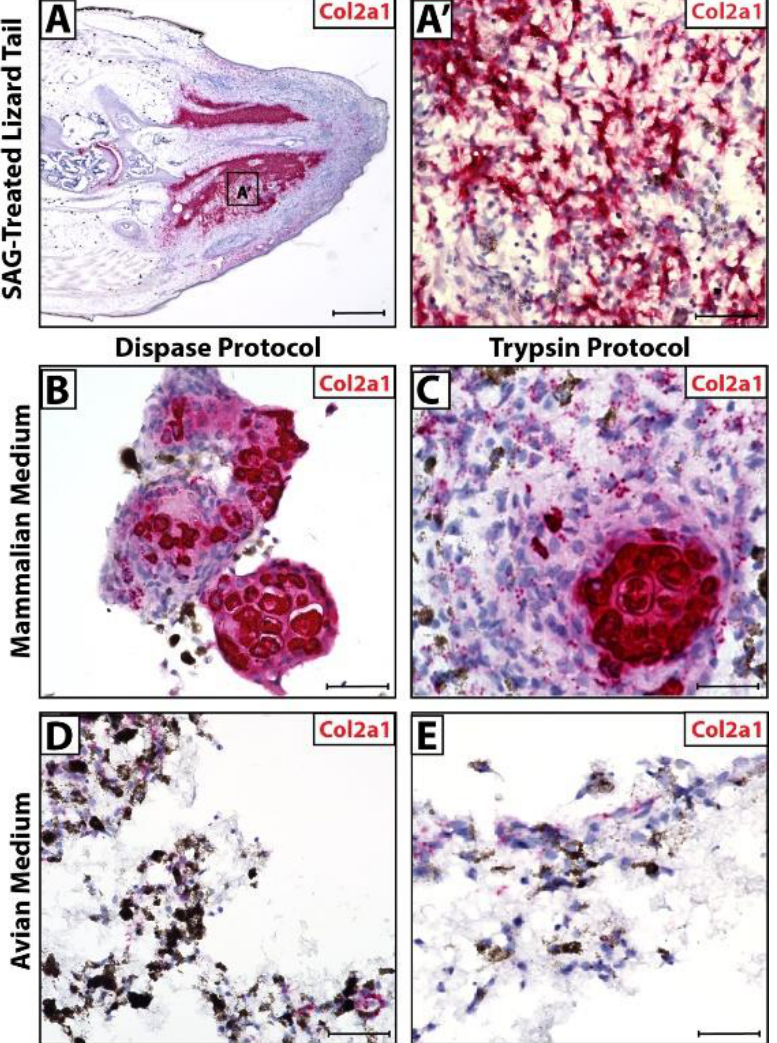
Figure 4. Micromass blastema organoid cultures mimic lizard tail regenerate cartilage formation in optimized dissociation protocol and media. ( A ) SAG-treated regenerated lizard tail (D28) analyzed via histology/in situ hybridization for Col2a1 expression. ( B ) Higher magnification of region identified in Panel A highlighting Col2a1 + ectopic cartilage region. ( B – E ) Col2a1 expression in cell pellets dissociated using ( B , D ) Dispase protocol or ( C , E ) Trypsin protocol, cultured in ( B , C ) mammalian media or ( D , E ) avian media and analyzed via histology/in situ hybridization for Col2a1 expression. ( A ) Scale bar = 500 µM. ( A’ , B – E ) Scale bar = 50 µM.